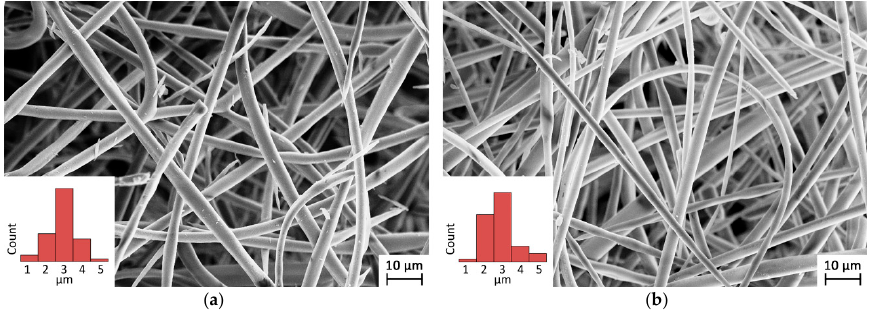
Figure 1. Scanning electron microscopy (SEM) image and fiber diameter distribution of the ( a ) as-spun polymer, and ( b ) thermal-treated